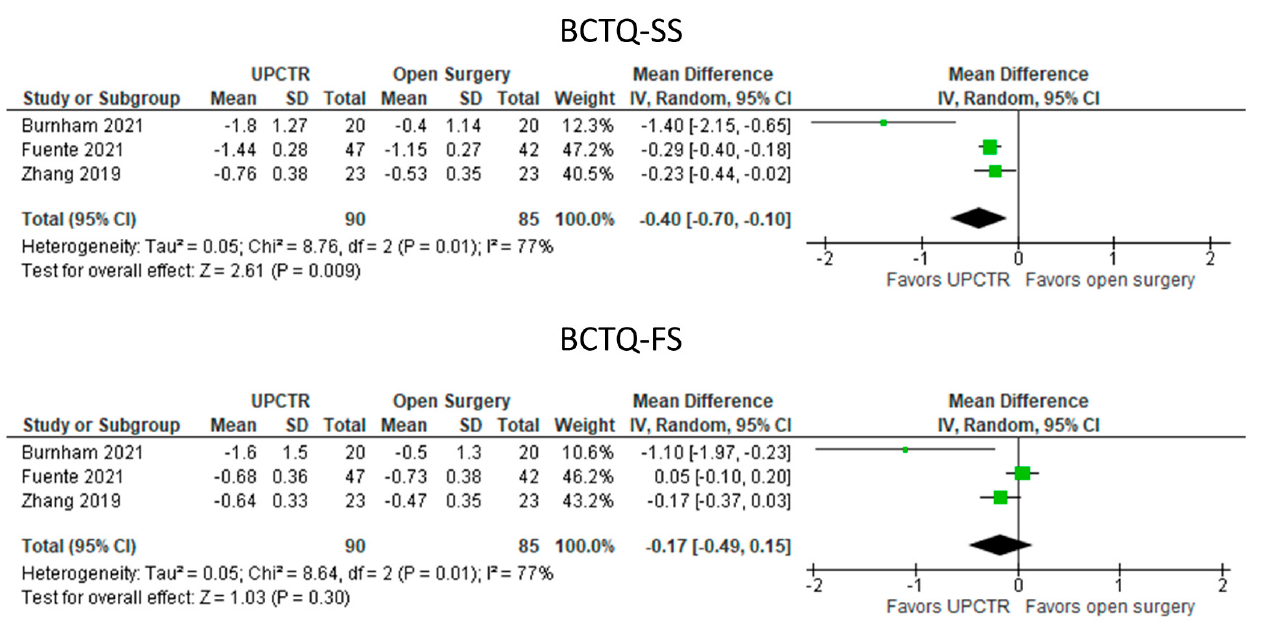
Figure 7. Meta—analysis of UPCTR vs. surgery. BCTQ—SS, The Boston Carpal Tunnel Question- naire—symptom scale; BCTQ—FS, The Boston Carpal Tunnel Questionnaire—functional scale. The green squares represent the differences between the means of each of the two groups compared, i.e. the mean differences. The size of the green square represents how much that individual study affects the overall outcome of the meta—analysis, i.e. the weight of the studies on the meta—analysis. The precision of the study depends on the 95% confidence interval for that mean difference, i.e. the length of the straight lines, the shorter the lines, the more precise the mean differences. The black trapezoid is the pooled mean difference of all the studies combined in consideration of the weight of each study, with its confidence interval extending from the left tip to the right tip.